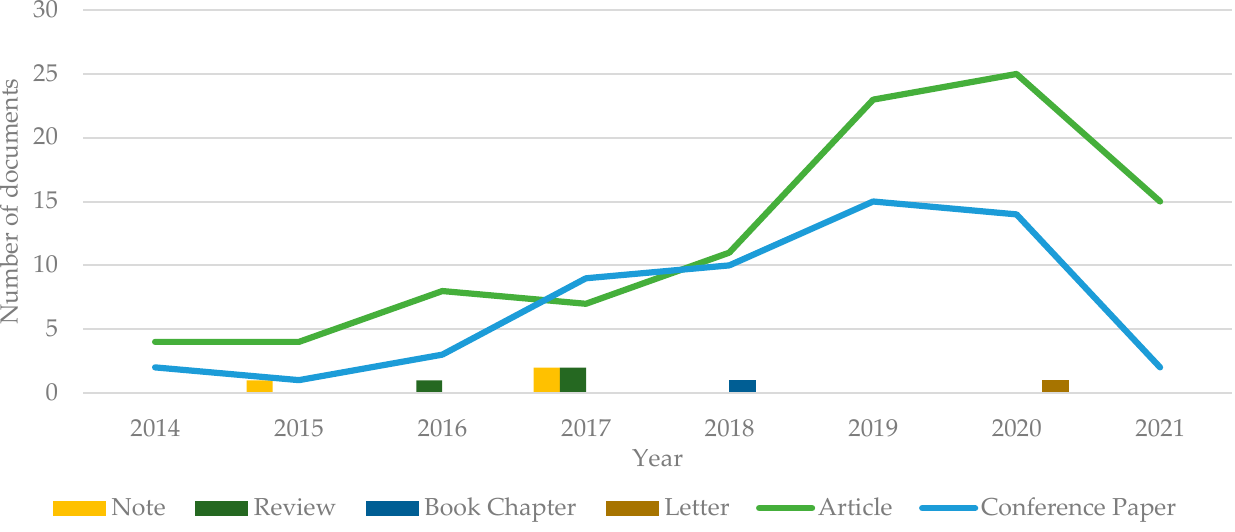
Figure 1. Evolution of Hyperloop academic research.